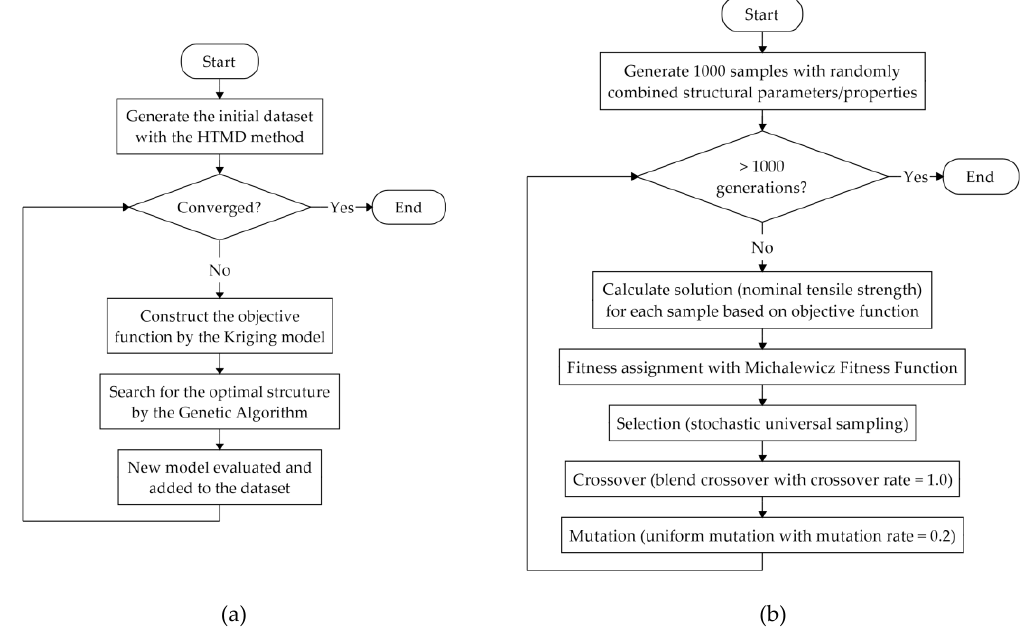
Figure 2. Flowchart of the optimization procedure. ( a ) Bayesian optimization; ( b ) genetic algorithm.